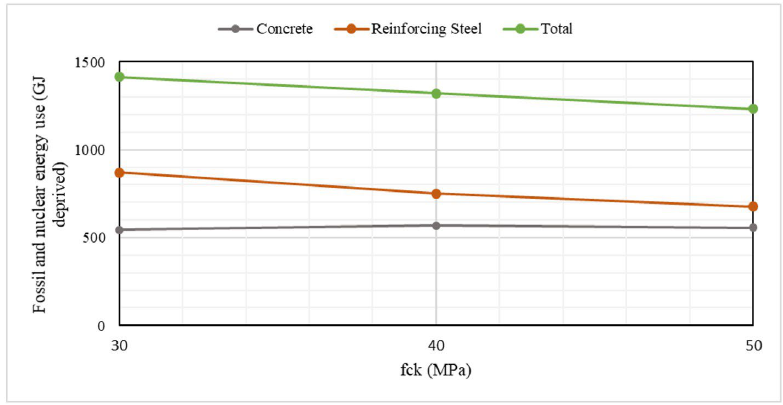
Figure 8. Fossil and nuclear energy use for RC columns